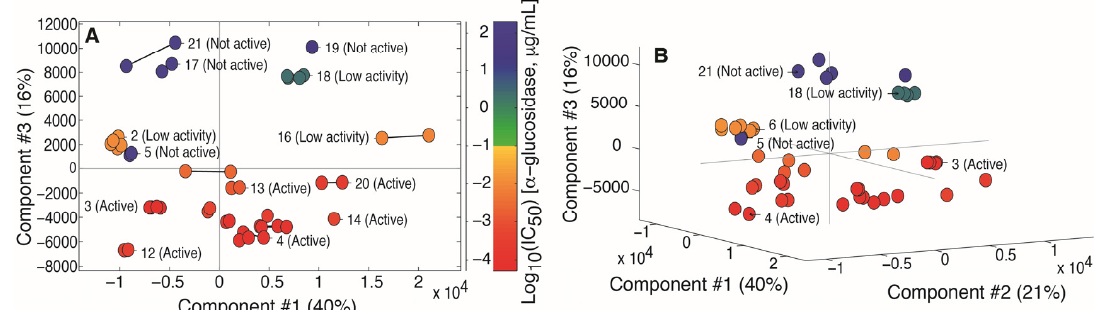
Figure 2. ( A ) Principal component analysis (PCA) scores plot of component #3 vs. #1 . Each marker represents one spectrum and solid lines between markers connect spectra of the same extract. The color of the markers represents the activity of the extracts in the α -glucosidase inhibition assay as described in the legend of Figure 1 and the color bar to the right. The numbers in parentheses are the percentage of the original variance that was captured in the specific component; ( B ) PCA scores plot of component #3 vs. #2 vs. #1 . Each marker represents one spectrum. The color represents the activity of the extracts in the α -glucosidase assay as described in the legend of Figure 1 (red = active samples, blue = non-active samples).